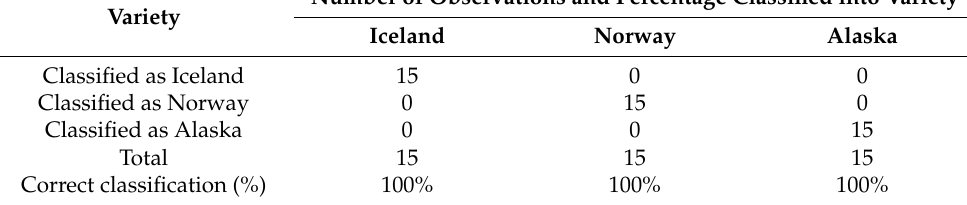
Table 4. Classification matrix of cross-validation for cod origin (Number of observations and percent classified into variety). Number of Observations and Percentage Classified into Variety